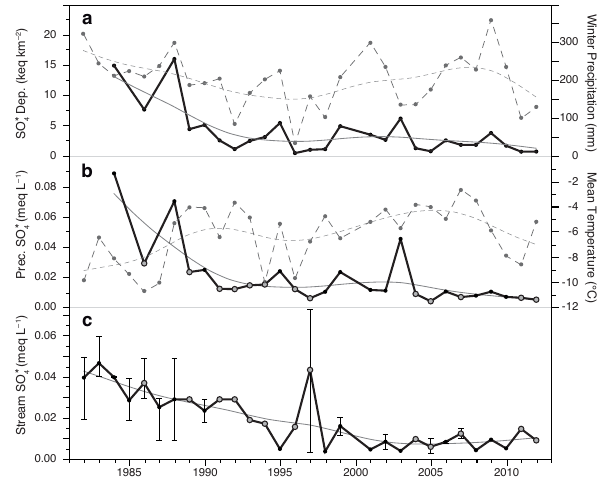
Fig. 10. Comparison of winter climate and deposition with non- marine sulfate (SO ∗ ) concentration in stream water after snow 4 melt over 30yr: (a) Total SO ∗ -deposition and precipitation (dashed 4 line) during November–Mar.; (b) SO ∗ - concentration in precip- 4 itation (snow) represented by precipitation weighted mean of monthly records Nov-March and mean air temperature (dashed line) November–March. (c) Mean SO ∗ -concentration in R. Djursvass- 4 lan 5004) stream water during spring flood (May). Error bars cover the range for years with multiple samples taken during May. Grey, enlarged points indicate years with higher SO ∗ concentration in 4 stream water after snowmelt than in winter precipitation. The thin trend lines are spline function fitted to the data. Air temperature is the average of the monthly mean temperatures recorded at the Sveg and Särna weather observatories (cf. Fig. 2). Precipitation and deposition data mainly originate from the Djursvallen precipitation monitoring station located close to the stream-sampling station. For years 1982–1983 and a few months where local observations were unavailable, missing data was imputed with the average of corre- sponding precipitation data from the Särna and Sveg